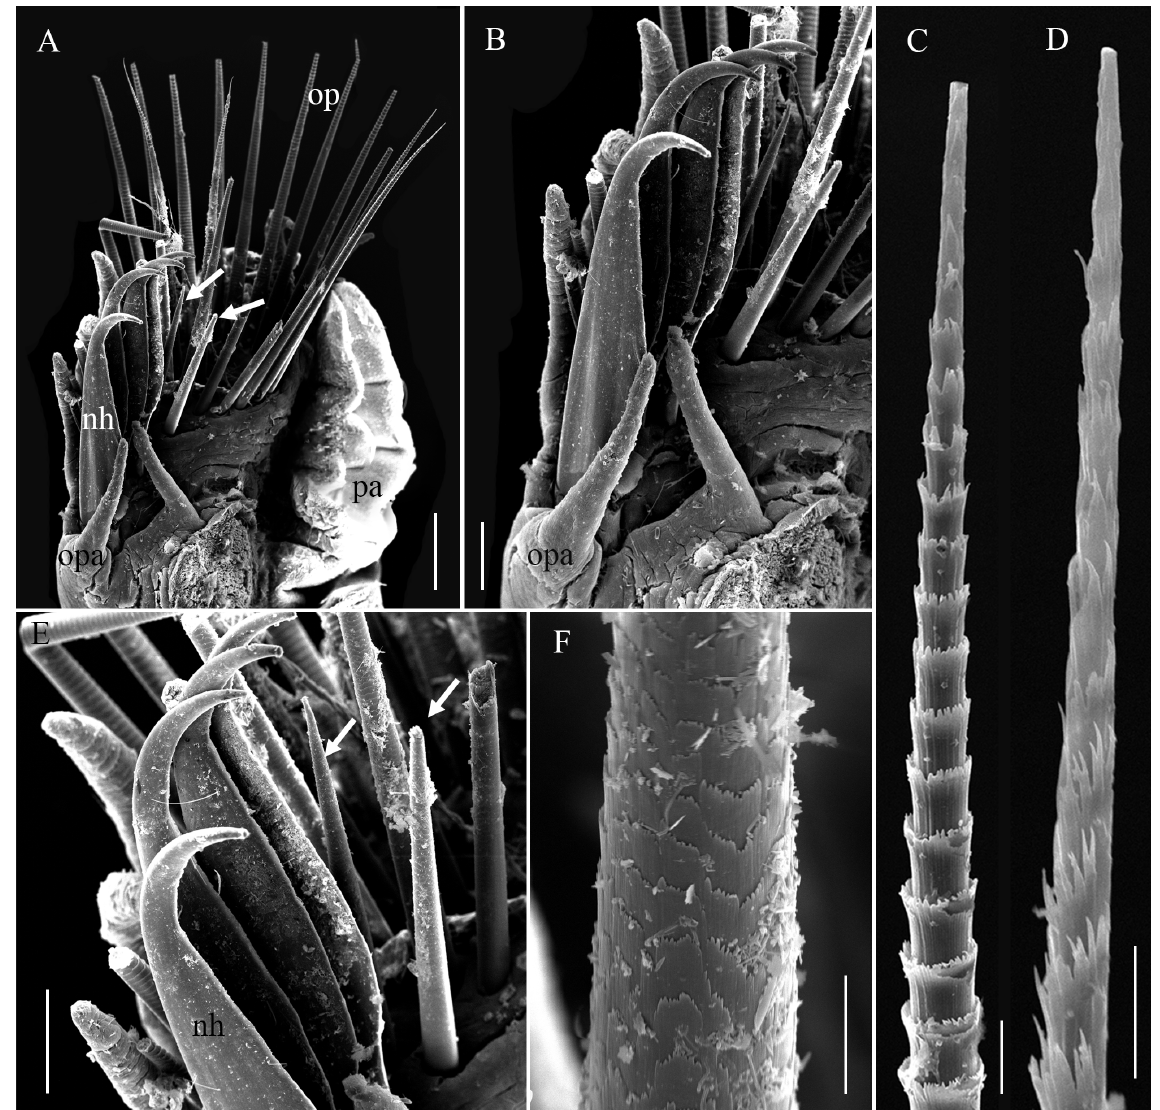
Fig. 11. Phalacrostemma dorothyae Kirtley, 1994 (UMML-22.1184). A . Left opercular lobe. B . Nuchal hooks. C . Outer palea. D . Tip of outer palea. E . Inner paleae. F . Thecae of inner palea. Abbreviations: nh = nuchal hooks; opa = opercular papillae; op = outer paleae; pa = palps. Arrows indicate inner paleae. Scale bars: A = 200 µm; B, E = 100 µm; C–D, F = 10